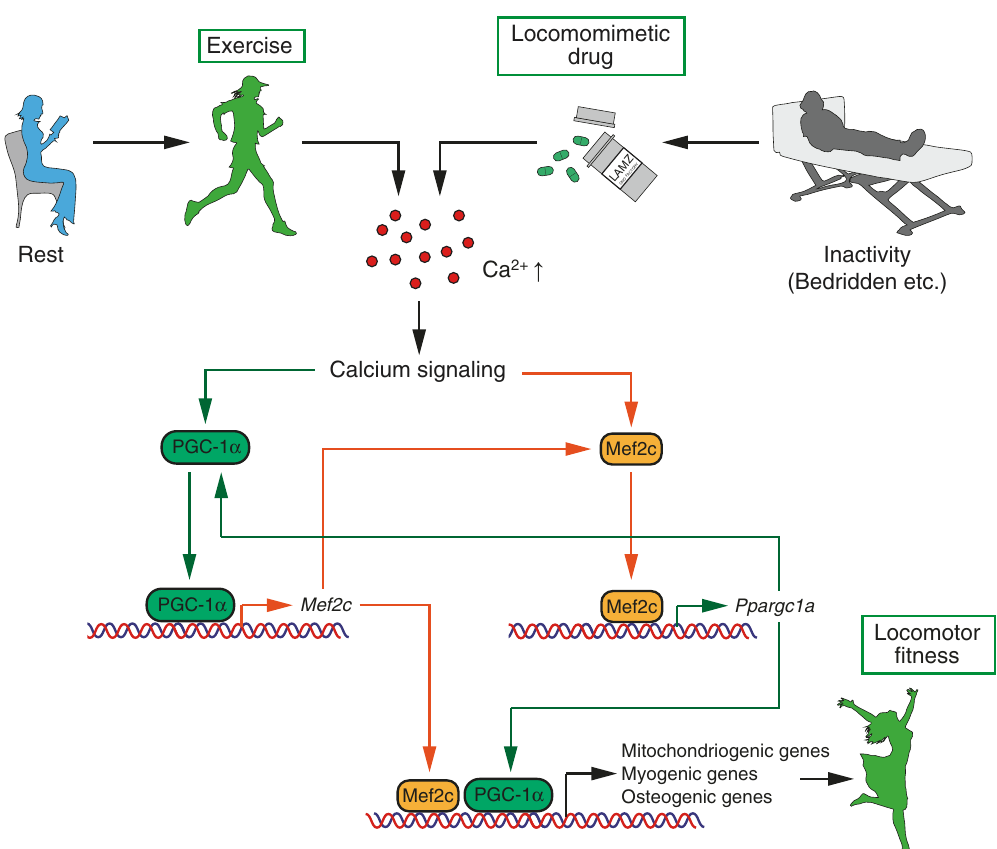
Fig. 7 LAMZ augments muscle and bone by mimicking calcium signaling to induce PGC-1 α . Schematic of LAMZ function in the augmentation of muscle and bone. Exercise increases the calcium concentration in muscle and bone cells, inducing calcium signaling. Under this signaling, PGC-1 α and Mef2c are activated and reciprocally drive their expression. Mitochondriogenic, myogenic and osteogenic genes are induced as well, together augmenting the muscle and bone. Thus, LAMZ facilitates the calcium signaling pathway and restores locomotor fi